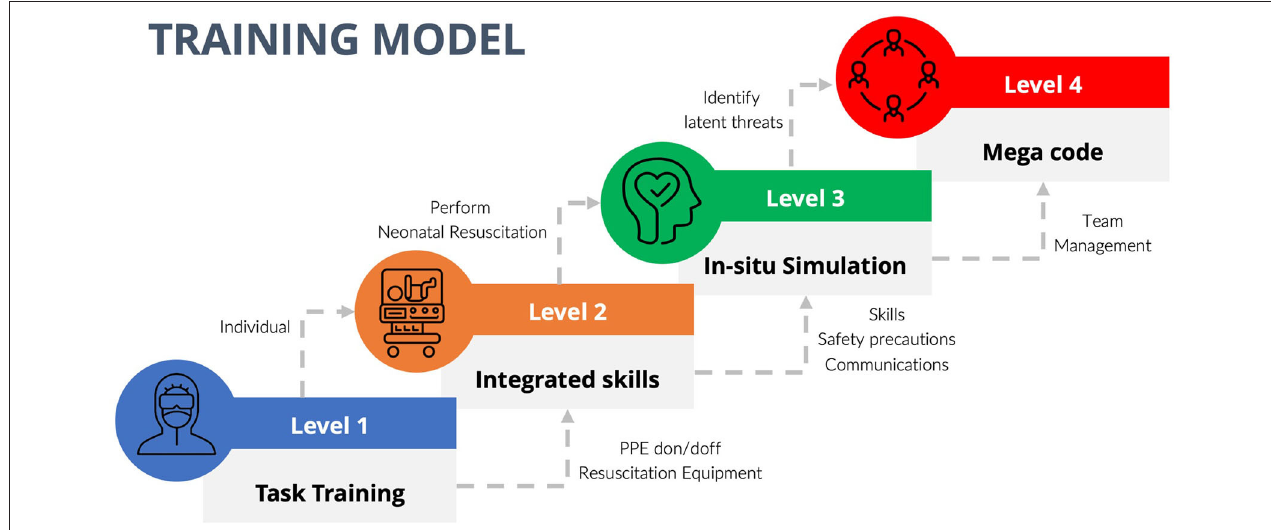
FIGURE 1 | Structured training model with progressive